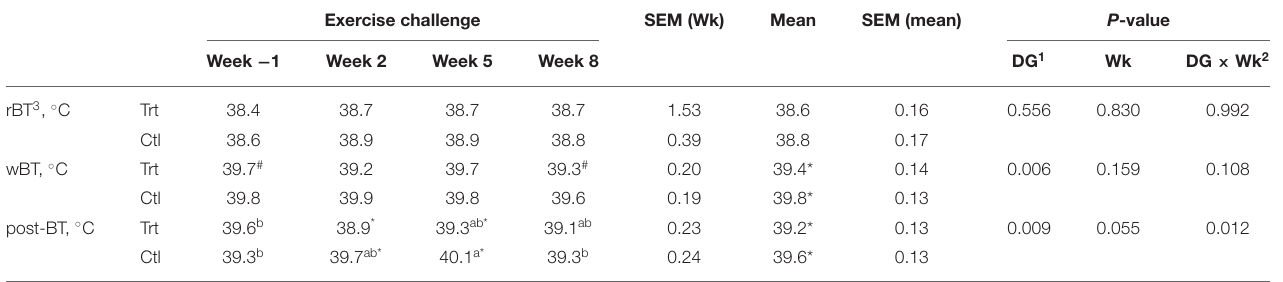
TABLE 3 | Mean internal body temperature ( ◦ C) at resting, working, and post-exercise state for control (0.74% soluble fiber on a dry-matter basis) and treatment groups (2.12% soluble fiber on a dry-matter basis) in sled dogs running at a pace of 20km/h for 3km. Exercise challenge SEM (Wk) Mean SEM (mean) P -value